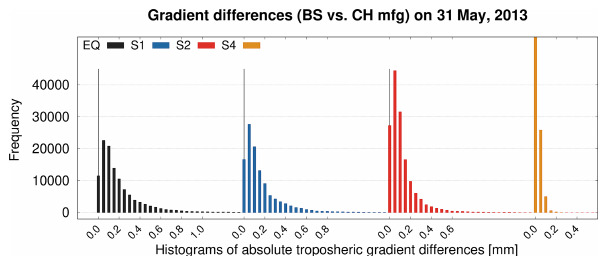
Figure 8. Differences in tropospheric gradients between Chen and Herring and Bar-Sever mfg for four observation weighting schemes: EQUAL (EQ), SINEL (S1), SINEL2 (S2), and SINEL4